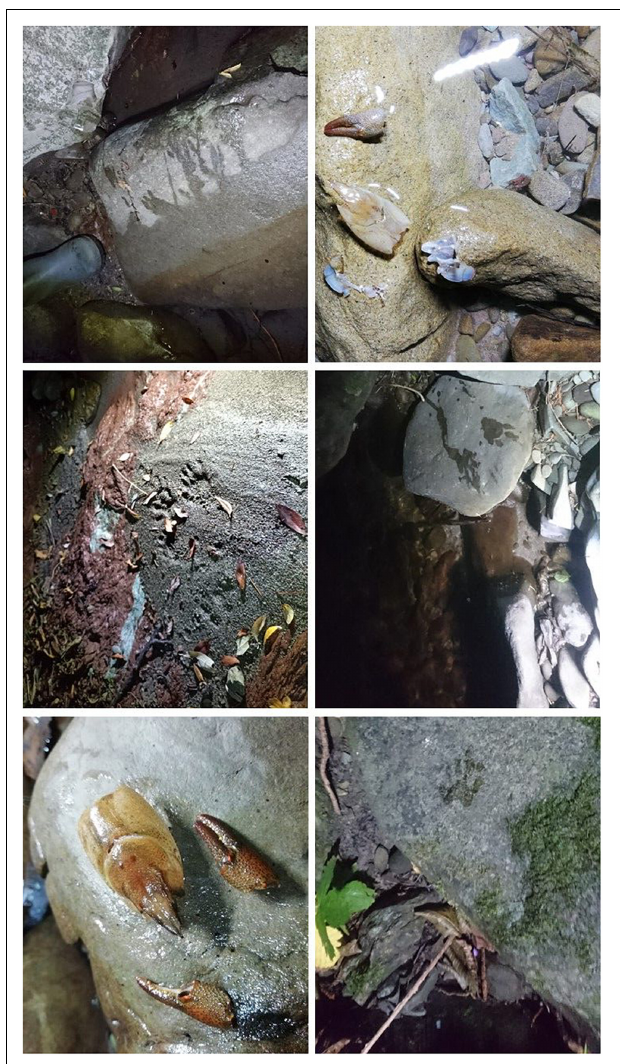
FIGURE 4 | Fresh footprints of raccoons and predated Austropotamobius pallipes complex specimens in the study area. Photos by© G.